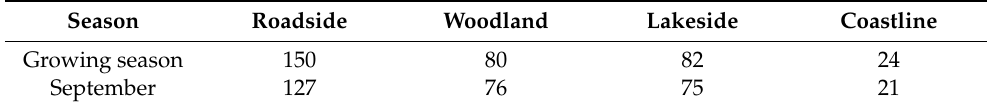
Table 4. Number of species of spontaneous plants in different habitats of the Tangdao Bay National Wetland